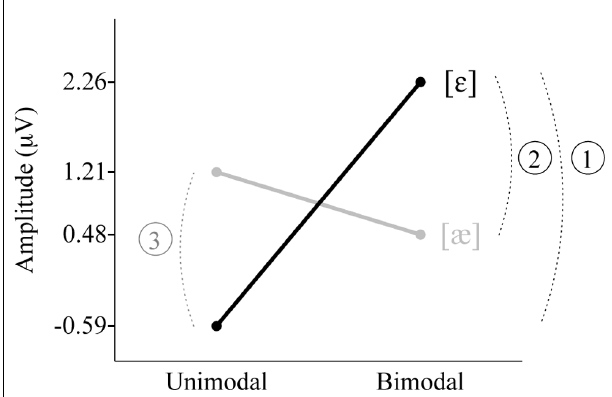
FIGURE 4 |Three post hoc significant differences in MMR amplitude between the four subgroups. Unimodal [ ε ] (left black), Unimodal [æ] (left gray), Bimodal [ ε ] (right black), Bimodal [æ] (right gray). Note: Among the four amplitudes, only the one for the Bimodal [ ε ] group differed from zero